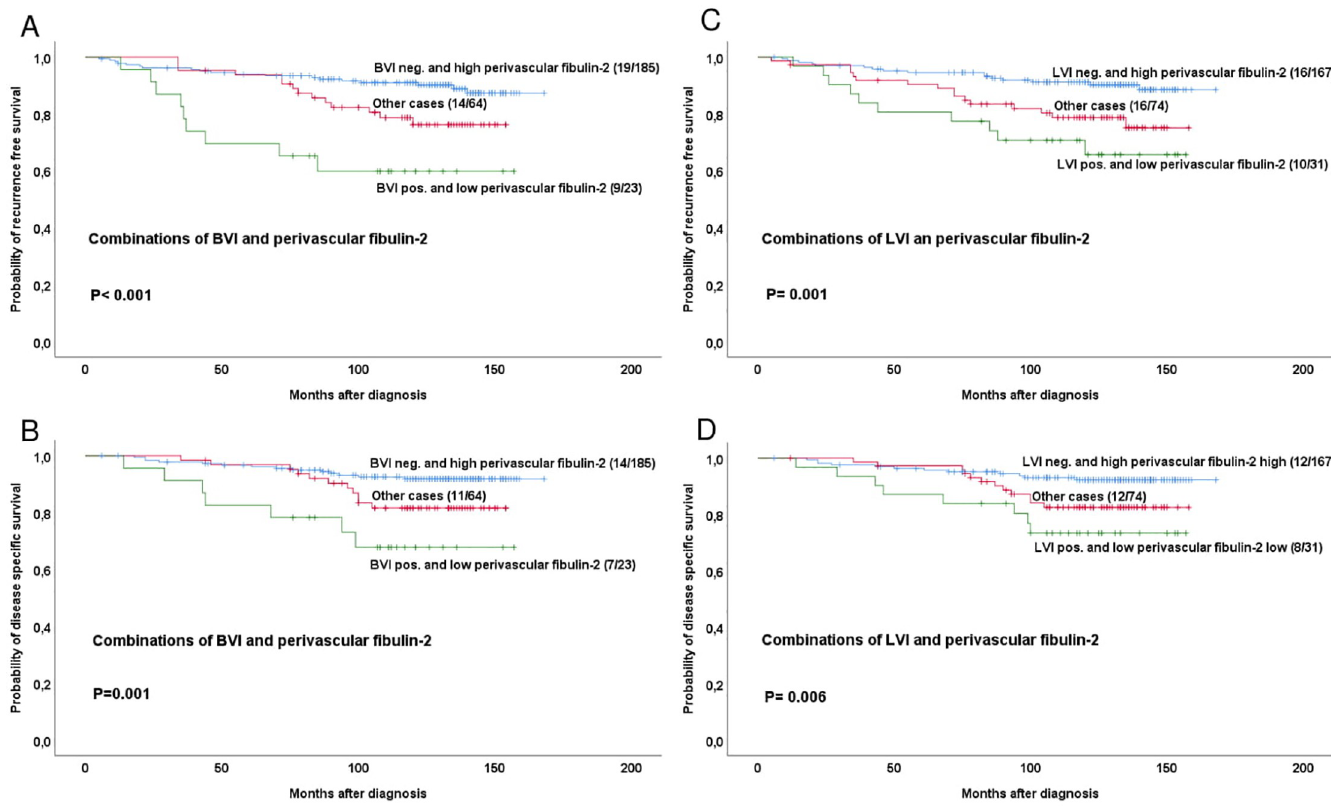
Fig 3. Estimated recurrence free and disease specific survival according to high-grade or low-grade perivascular fibulin-2 expression in combinations with BVI or LVI positive or negative cases. Survival curves are estimated by the Kaplan-Meier method (with log-rank test for differences). For each category, number of events / total number of cases are given. The category ‘other cases’ is defined as BVI positive with high perivascular fibulin-2 or BVI negative with low perivascular